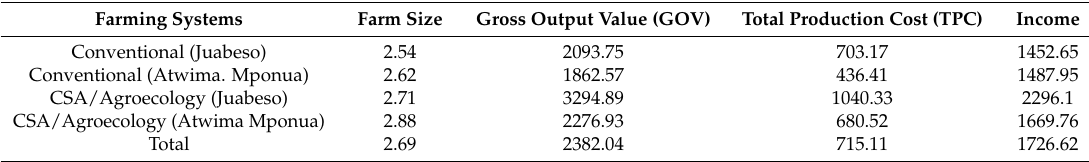
Table 6. Average Farm Size in Hectares and Income Indicators in Ghana Cedis per Hectare (GHS/Ha). Farming Systems Farm Size Gross Output Value